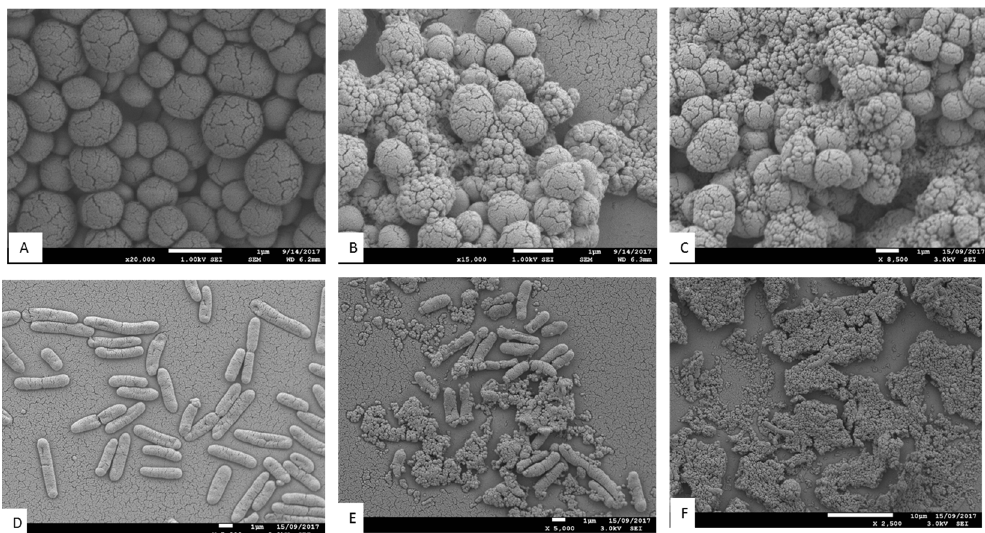
Figure 4. Antimicrobial activity of methanolic ASE of T. ferdinandiana fruits and leaves. Scanning electron microscopy (SEM) images of methicillin resistant Staphylococcus aureus control ( A ), effect of fruit extracts ( B ), effect of leaf extracts ( C ), and clinical isolates of Pseudomonas aeruginosa control ( D ), effect of fruit extracts ( E ) and effect of leaf extracts ( F ). Samples were imaged in a Jeol JSM 7100F field emission SEM at an accelerating voltage of 1 kV.